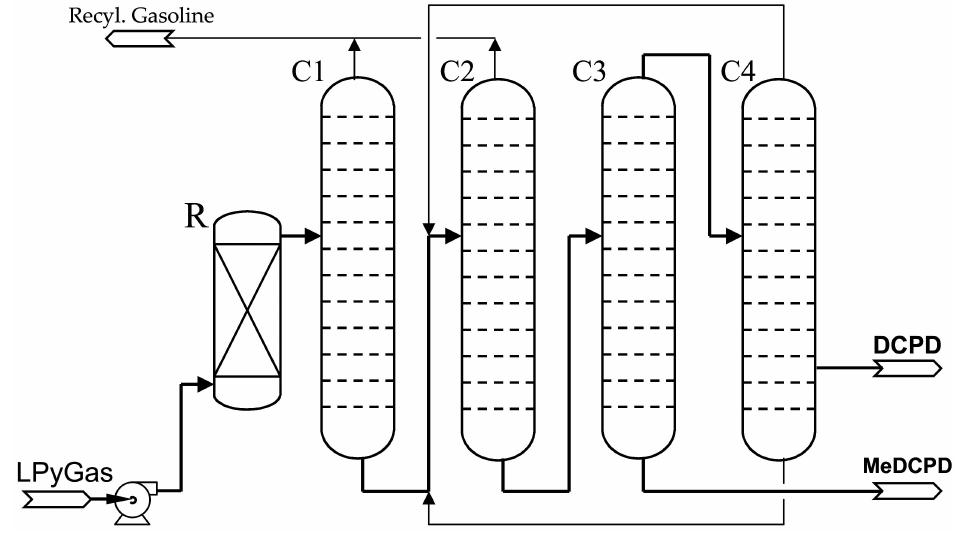
Figure 2. Process scheme for DCPD recovery from light pyrolysis gasoline